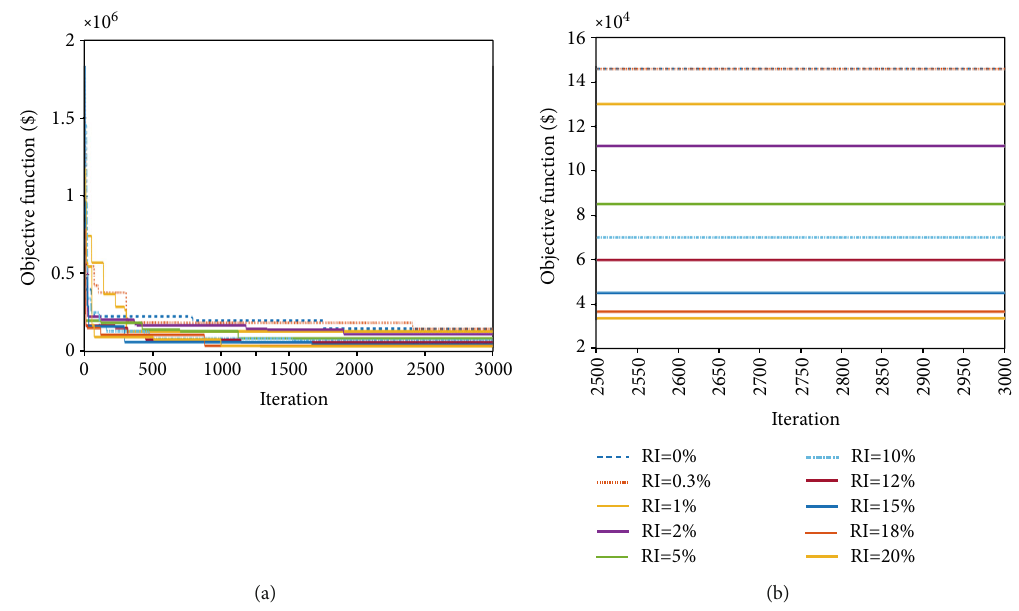
Figure 9: (a) The convergence characteristic of di ff erent reliability indexes on optimal hybrid solar/battery system; (b) zoom